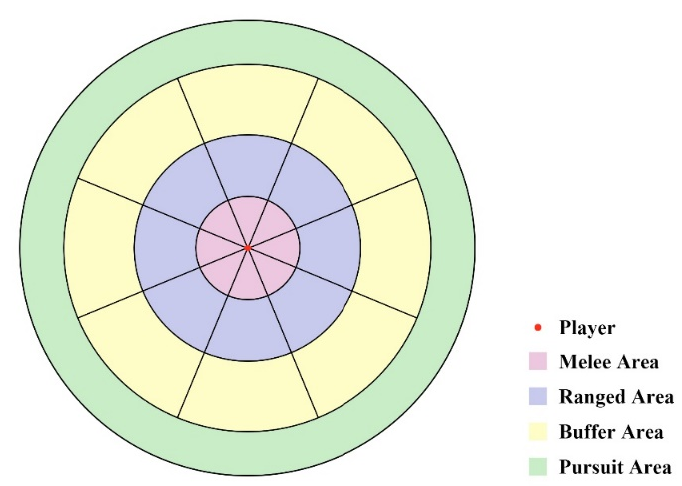
Figure 2. MRBP Ring Model.